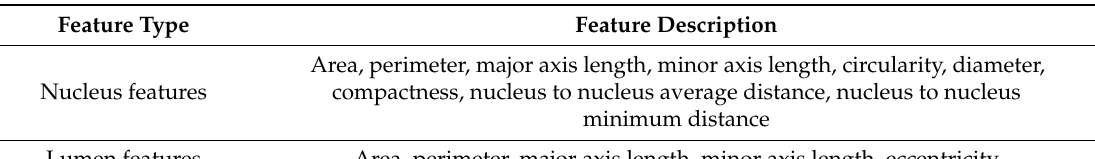
Table 1. Proposed features for support vector machine (SVM) binary classification to classify Gleason grading of prostate